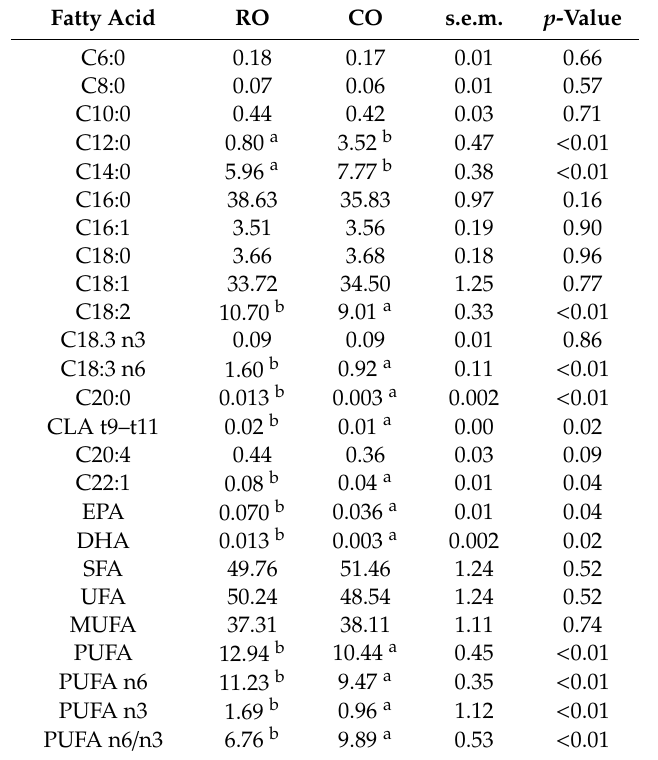
Table 4. Fatty acids composition (% of total fatty acids) of sows milk fed with di ff erent